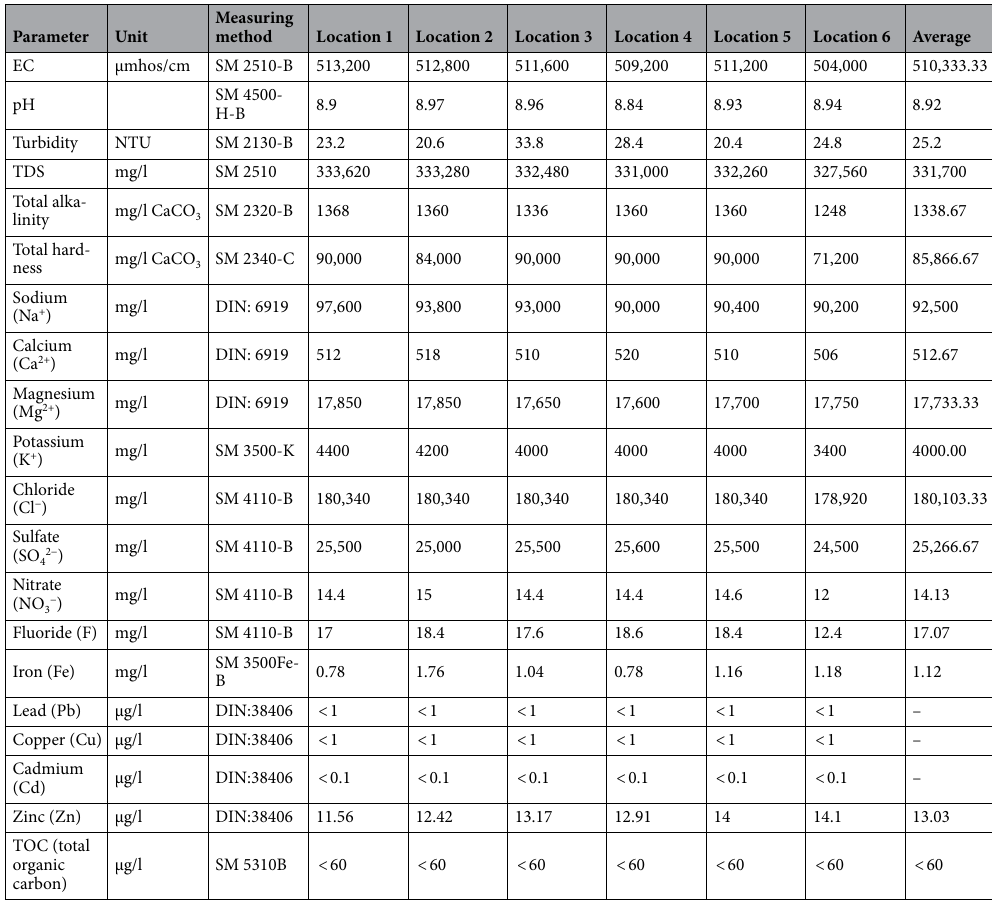
Table 1. Physico-chemical characteristics of the Lake Urmia. SM , Standard Methods for the Examination of Water and Wastewater, 23rd Edition. DIN , German Institute for Standardization.